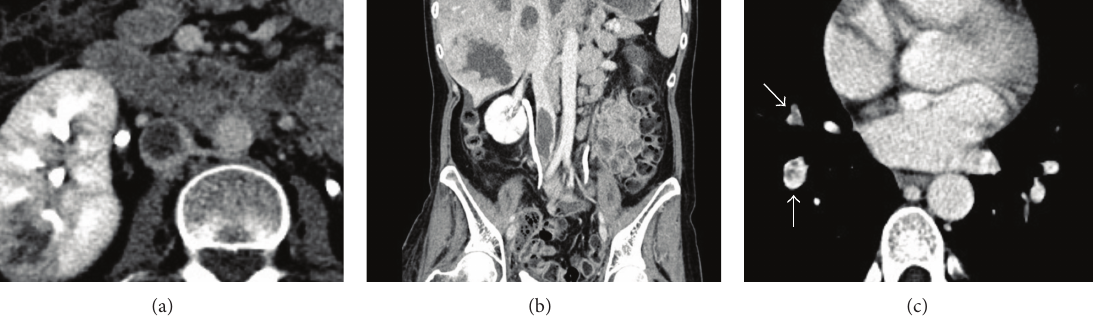
Figure 2: Contrast-enhanced abdominal ((a) and (b)) and chest (c) computed tomography. A massive, floating thrombus (approximately 1 8×2 0 mm) extended from the right common iliac vein to the infrarenal inferior vena cava; an intra-arterial thrombus occluded a right lower lobe pulmonary